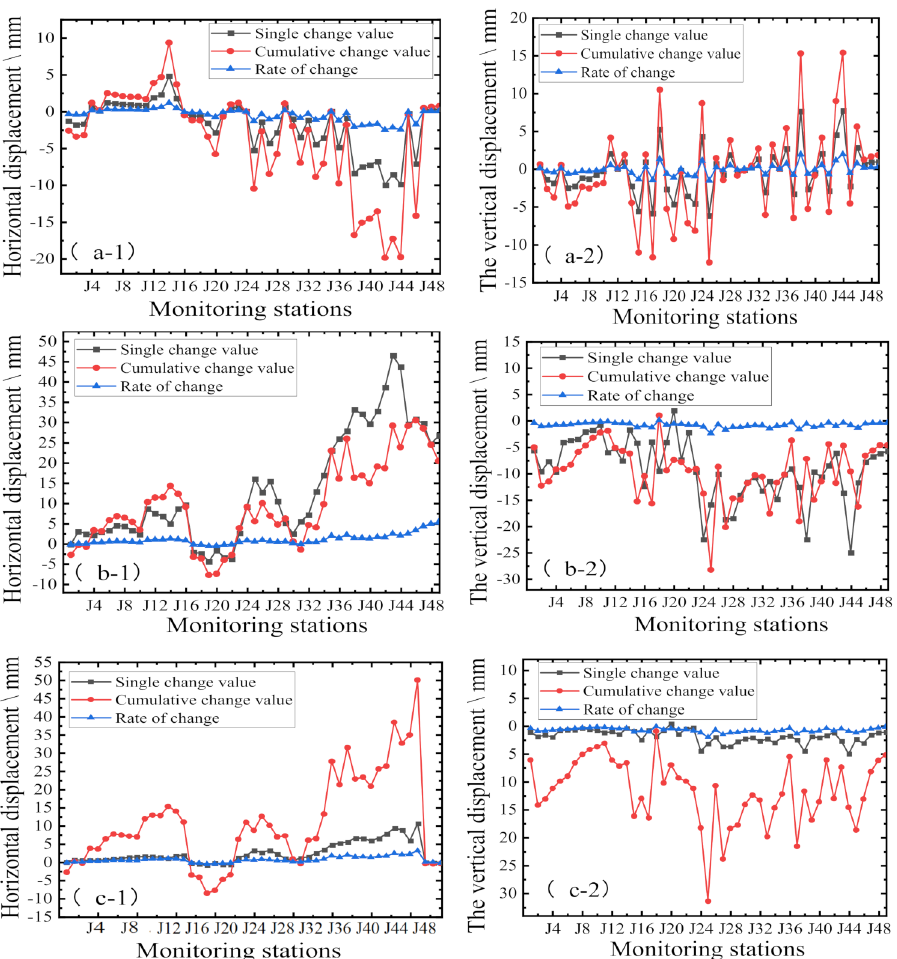
Figure 8. Displacement-monitoring data: The first-month displacement-monitoring data (( a-1 ) horizontal displacement; ( a-2 ) vertical displacement); the second-month displacement-monitoring data (( b-1 ) horizontal displacement; ( b-2 ) vertical displacement); the third-month displacement- monitoring data (( c-1 ) horizontal displacement; ( c-2 ) vertical